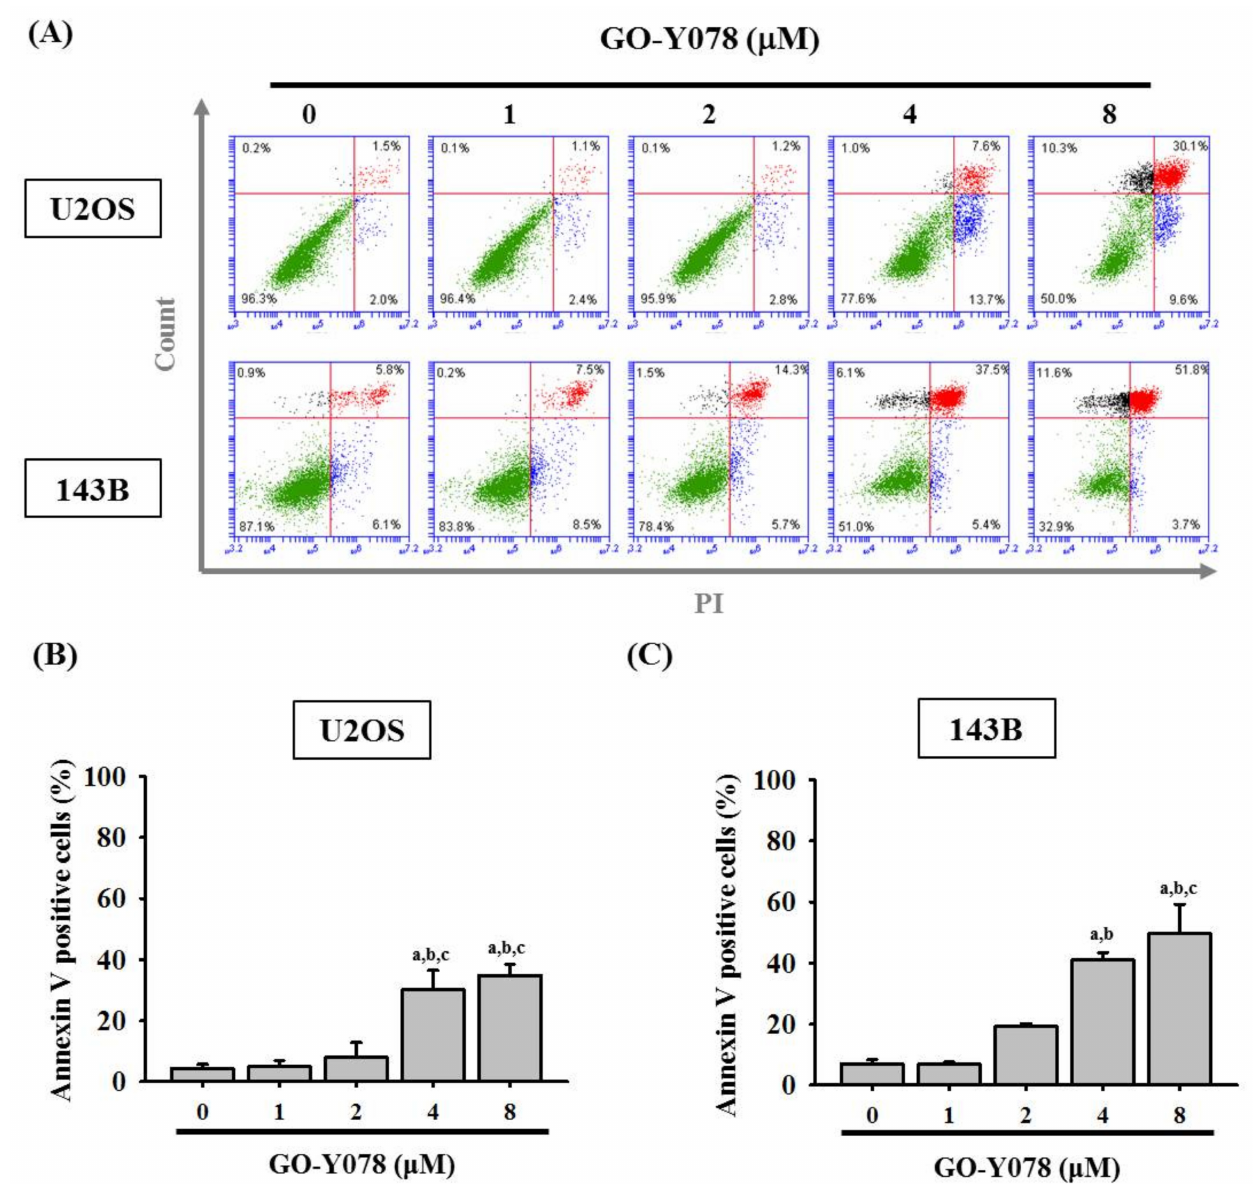
Figure 3. Effects of GO-Y078 on the cycle apoptosis in U2OS and 143B cells. U2OS and 143B were treated with GO-Y078 (1, 2, 4, and 8 µ M) for 24 h and then subjected to flow cytometry after ( A ) PI and Annexin V-FITC/PI staining to analyze DNA contents. Cells that were considered viable were FITC Annexin V and PI negative; cells that were in early apoptosis were FITC Annexin V positive and PI negative; cells that were in late apoptosis or already dead were both FITC Annexin V and PI positive. ( B ) Thereupon quantitative analyses of early apoptosis and late apoptosis of ( B ) U2OS and ( C ) 143B cells were summed up to differentiate apoptosis from necrosis. Results are shown as mean ± S.D. n = 5. ANOVA analysis with Tukey’s posteriori comparison was used. U2OS: F = 47.309, p < 0.001; 143B: F = 9.663, p < 0.001. a Significantly different, p < 0.05, when compared to control. b Significantly different, p < 0.05, when compared to 1 µ M. c Significantly different, p < 0.05, when compared to 2 µ